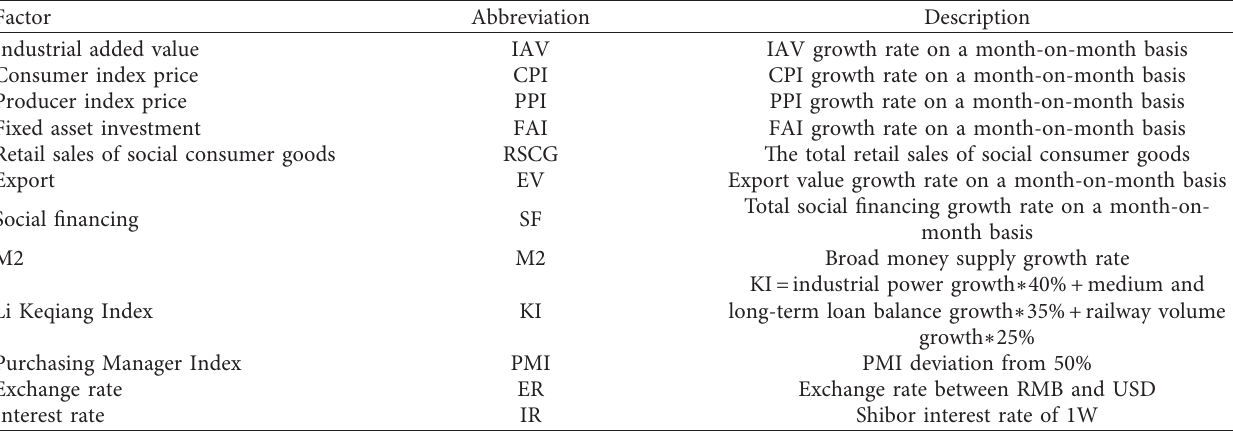
Table 2: Macroeconomic factors list.